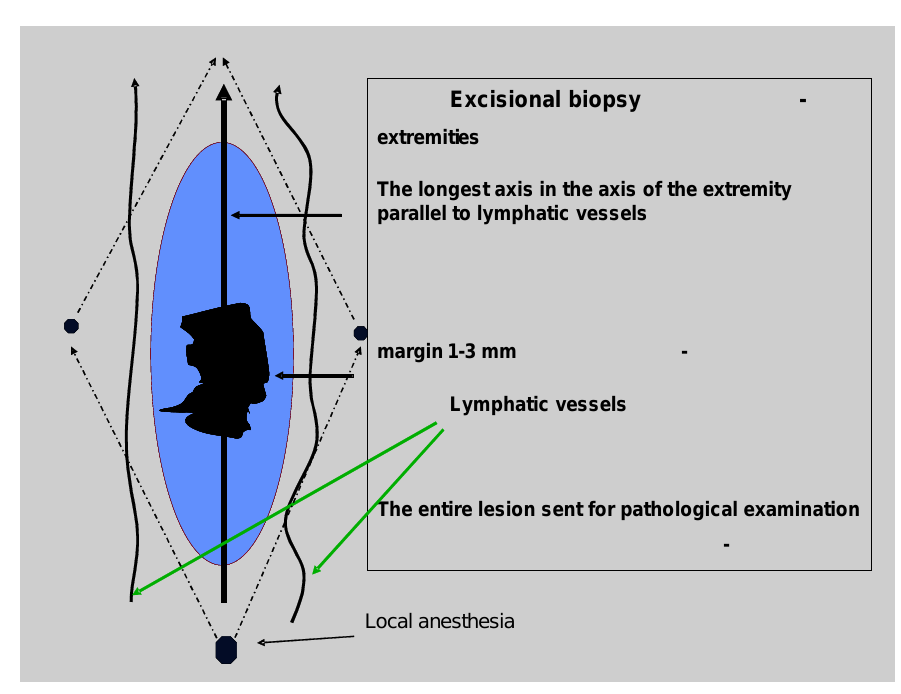
Figure 1. Practical considerations of excisional biopsy of a skin lesion suspicious of being melanoma (courtesy of W. Ruka)